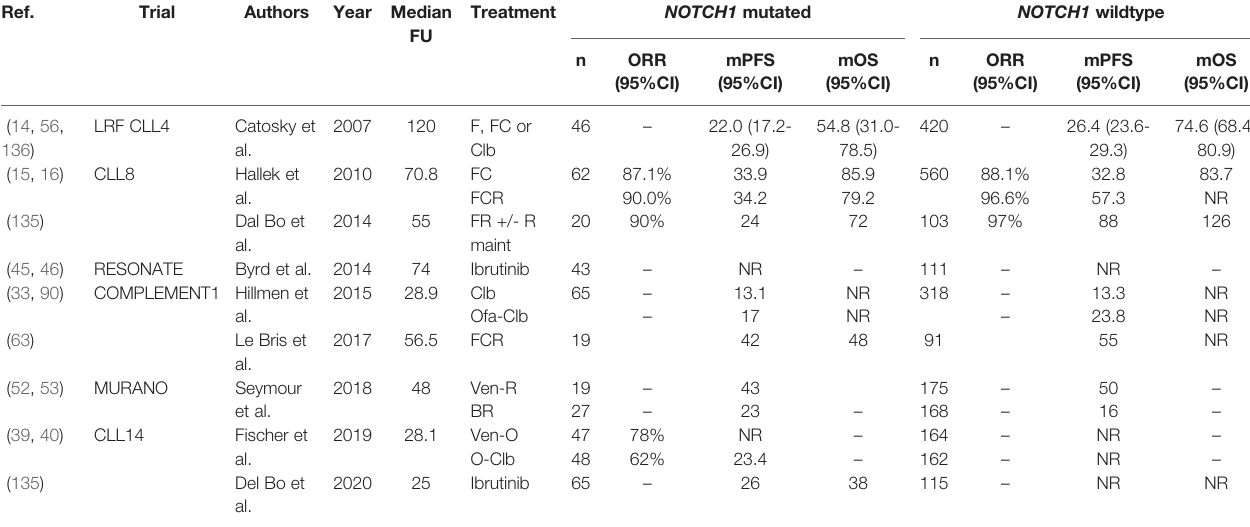
TABLE 8 | An overview of clinical trials comparing treatment regimens in patients with NOTCH1 mutated CLL.